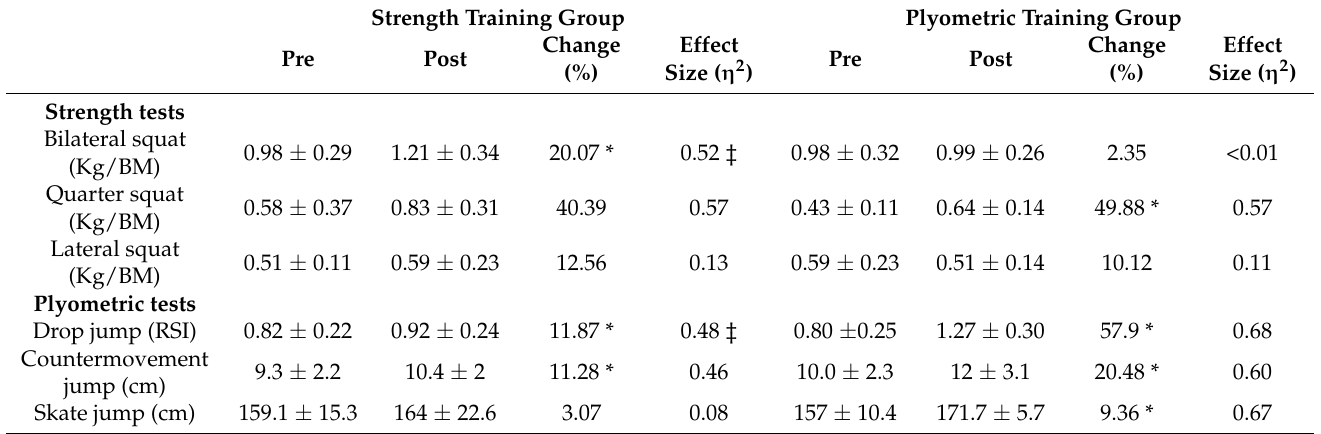
Table 3. Descriptive statistics of performance changes from pre- to post-test for both groups in the different strength and plyometric